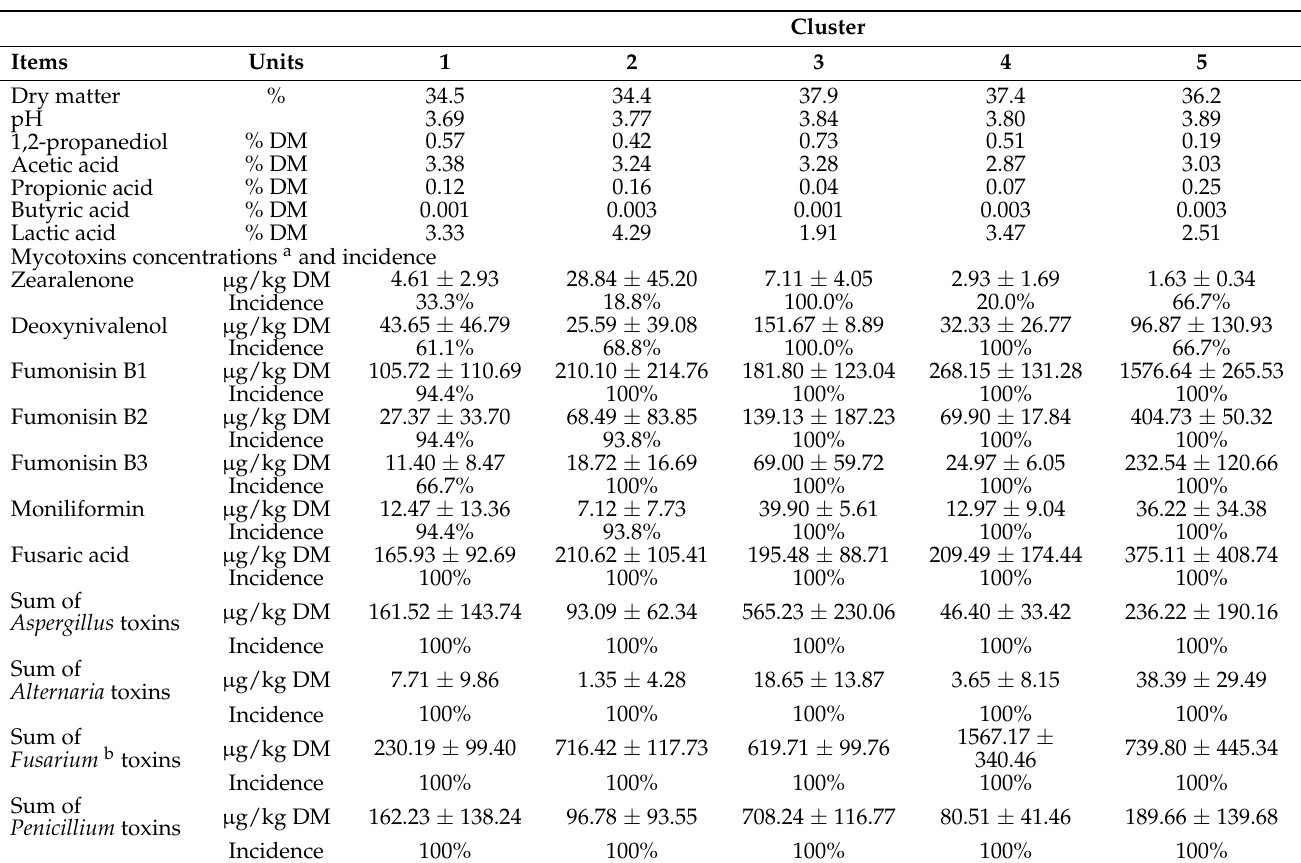
Table 2. Descriptive statistics for dry matter, fermentative traits, and mycotoxins concentrations of corn silage belonging to the five different clusters. For more details see Gallo et al.